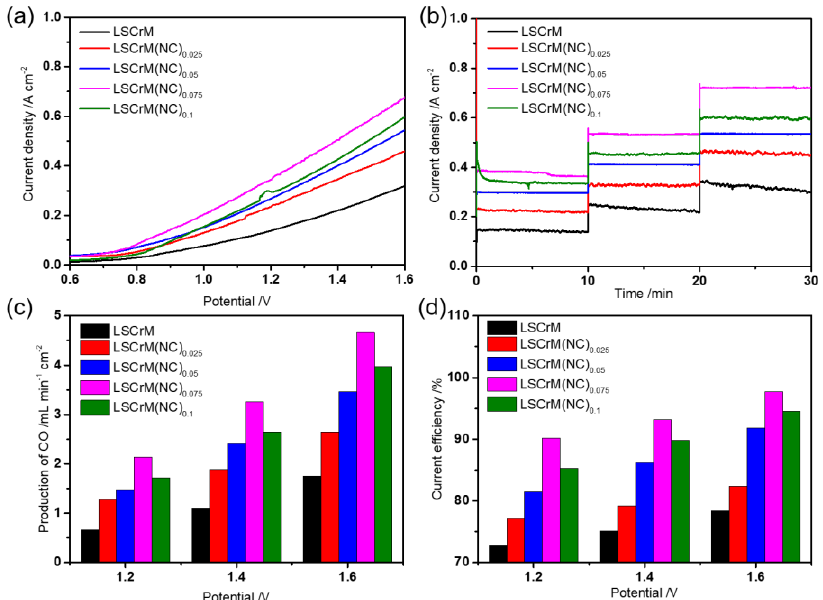
Figure 5. Performance diagram of LSCrM(NC) x − SDC. ( a ) Transient current, ( b ) short − term current, ( c ) CO yield from electrolytic CO 2 at different voltages and ( d ) corresponding Faraday current efficiency. Table 1. The summary of electrochemical performance of the perovskite cathode doped with different metal elements.